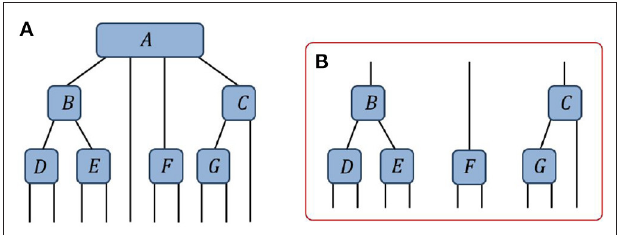
FIGURE 7 | (A) An example of a tree tensor network (TTN), here composed of 7 tensors. (B) The three (non-trivial) branches of the tree with respect to choosing A as the root tensor.